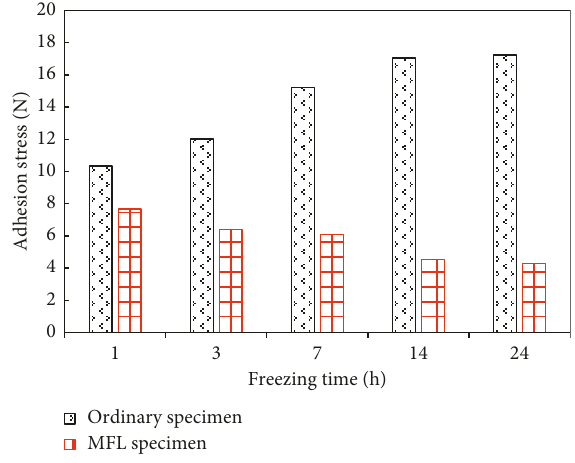
Figure 14: Adhesion variation with freezing time.